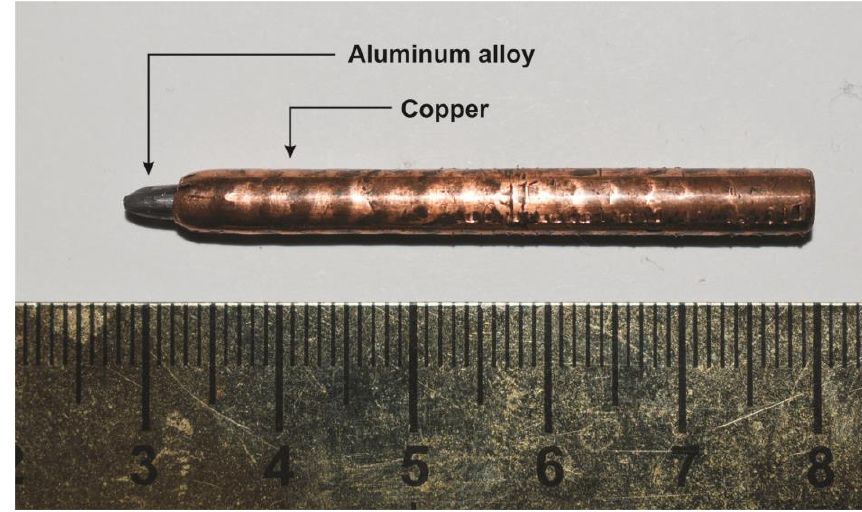
Figure 9. The appearance of the 5-mm diameter composite sample after tensile test.